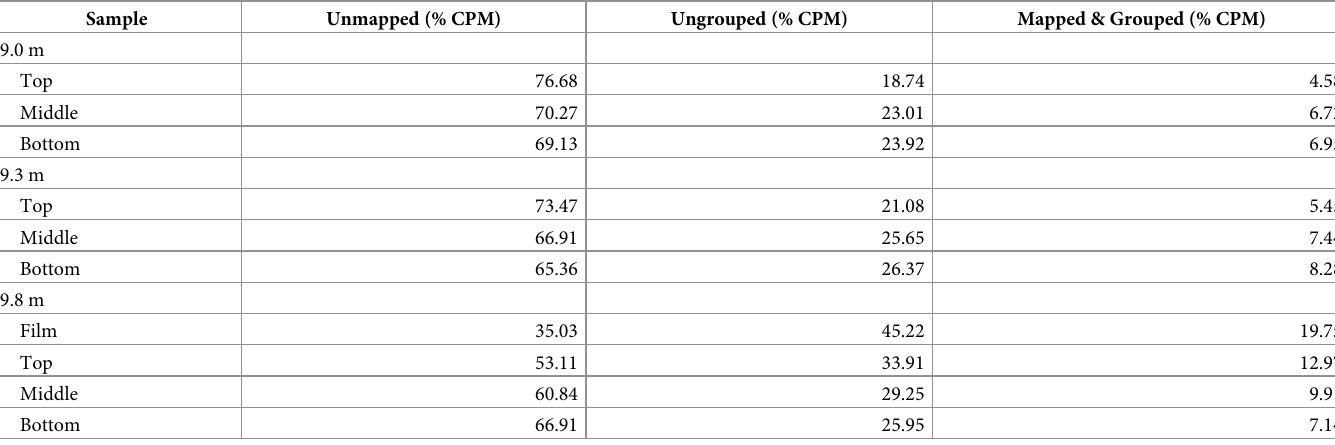
Table 2. Mapping and grouping of reads.